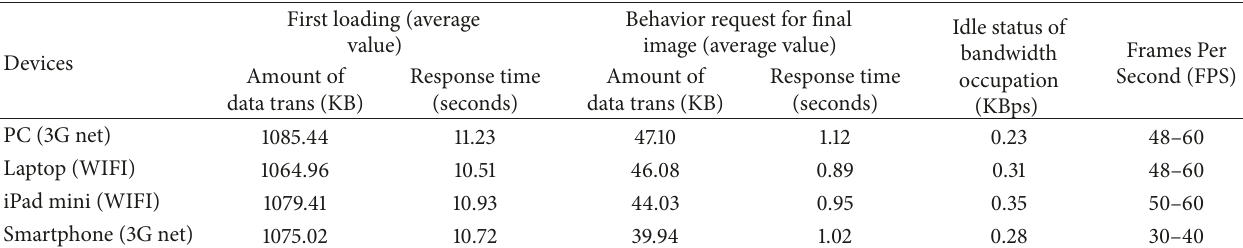
Table 3: Average response time and amount of data transmission from the different behaviors and devices at 100-KBps.